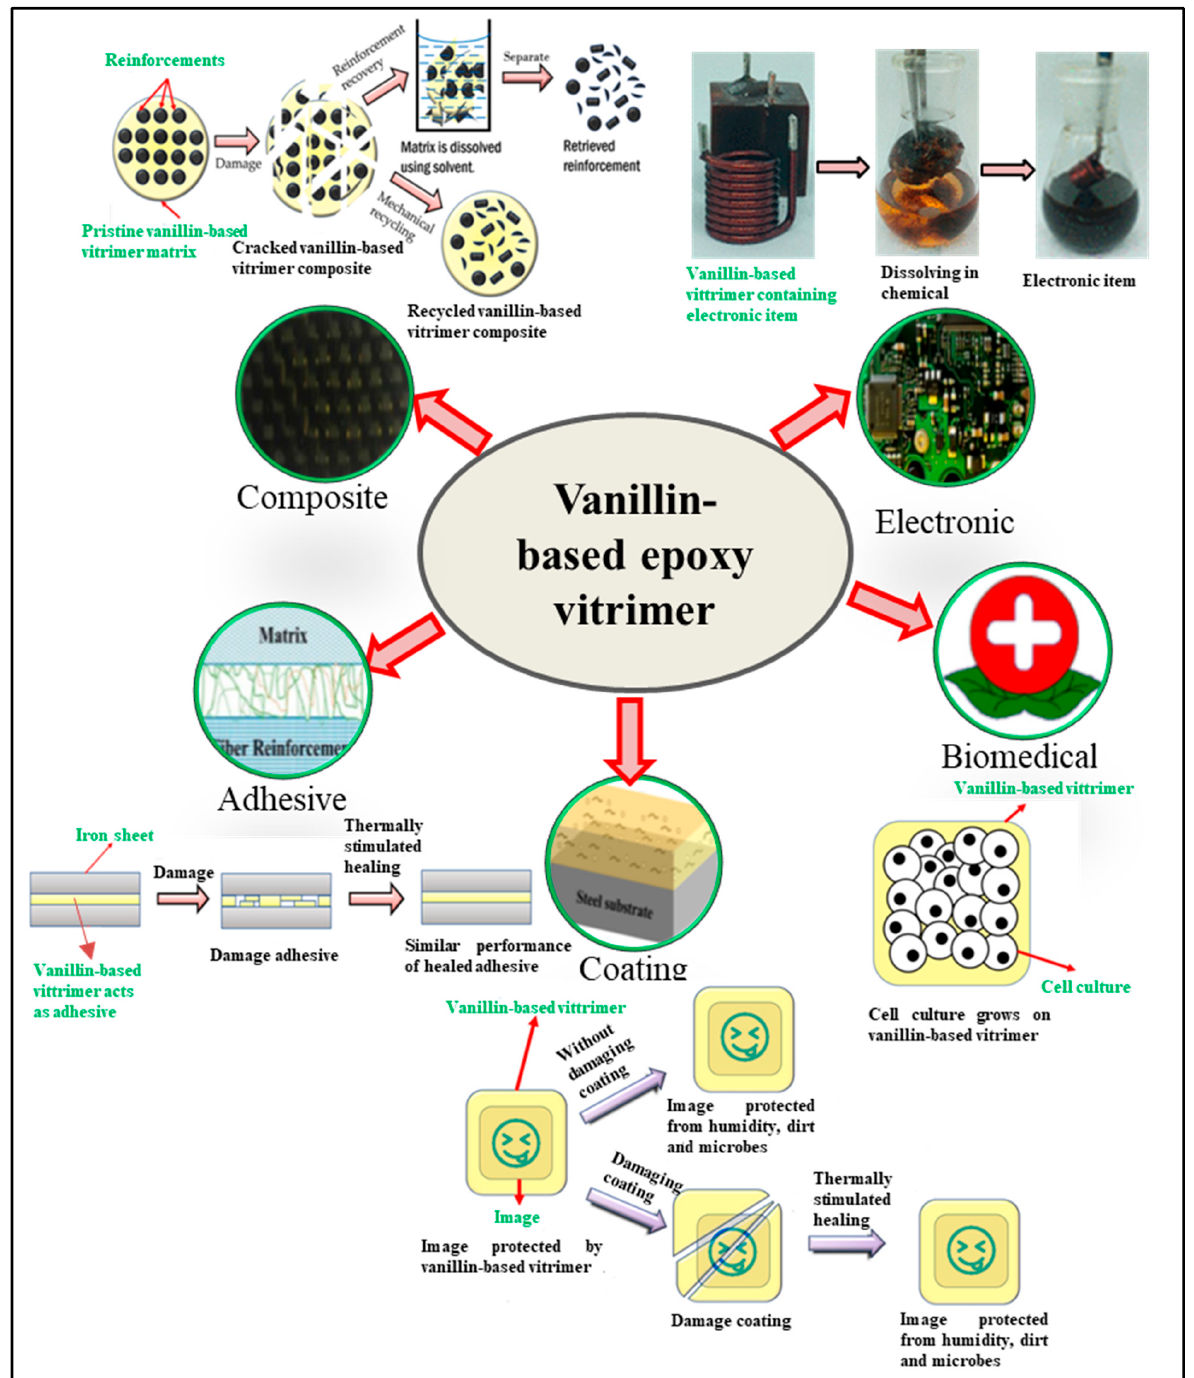
Figure 21. Potential applications of vanillin-modified epoxy vitrimers.